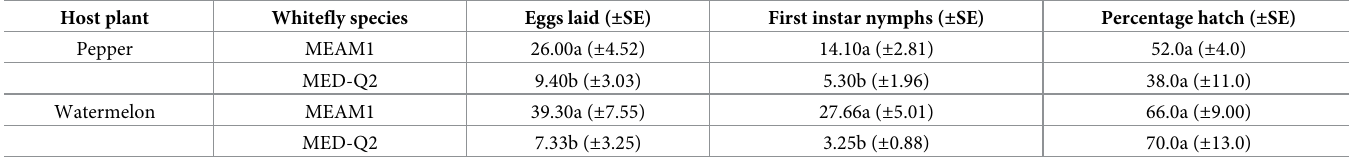
Means followed by different letters within columns indicate significant difference (p < 0.05) between MEAM1 and MED-Q2 on each host plant for each parameter